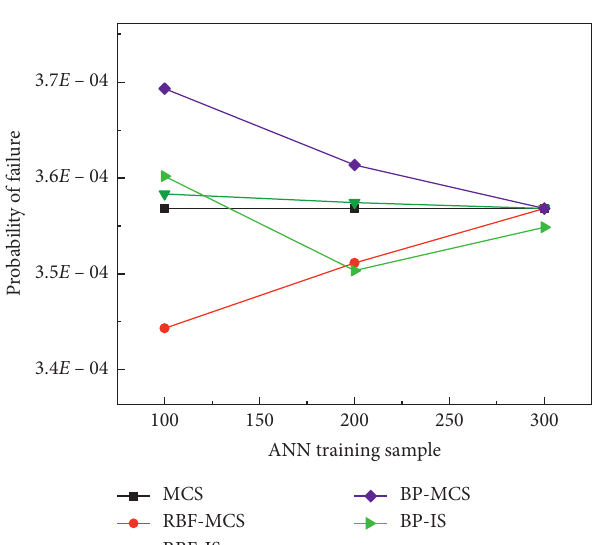
Figure 6: Comparison of the POF between ANN-IS (RBF-IS and BP-IS) and various other methods relative to ANN sample data